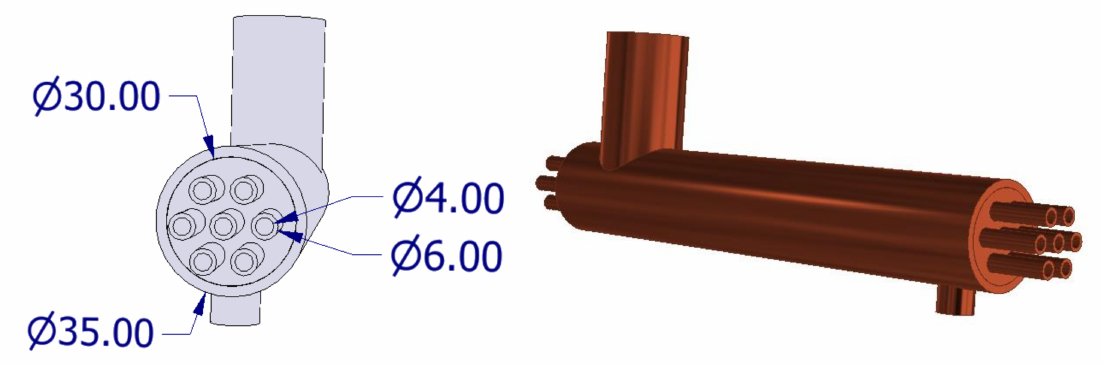
Figure 2. General view of the shell-and-tube